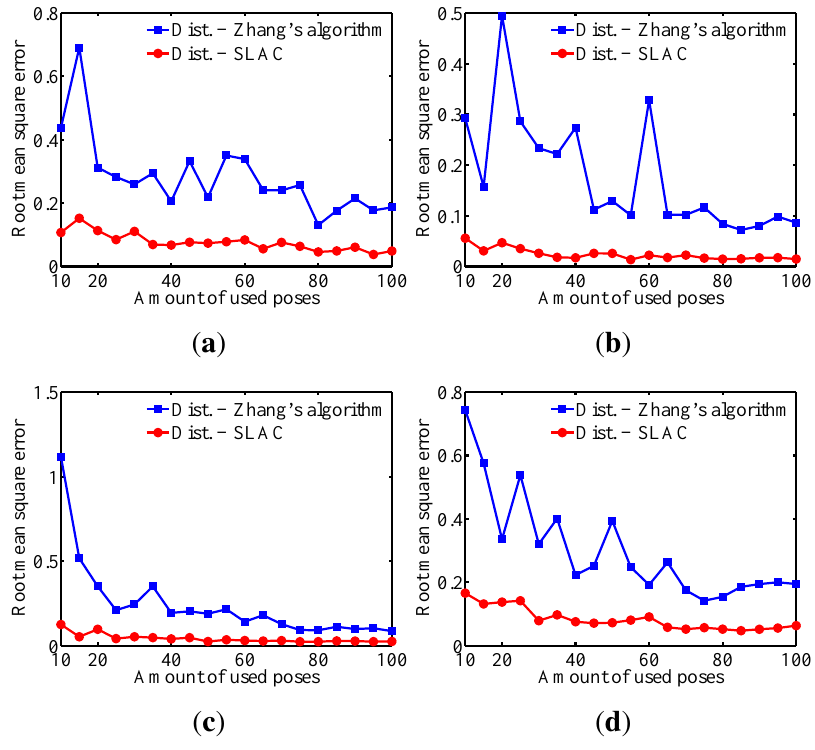
Figure 13. Simulation results for the radial distortion parameters for different amounts of